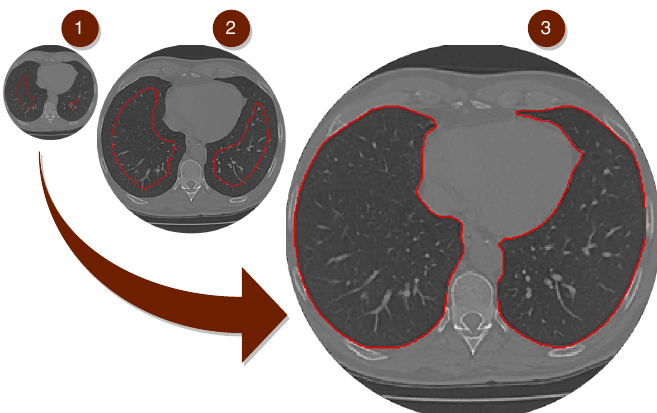
Figure 5. The Figure above shows the segmentation of the lung using our Composite Method, based on deep learning combined with the Parzen window method through Transfer Learning.